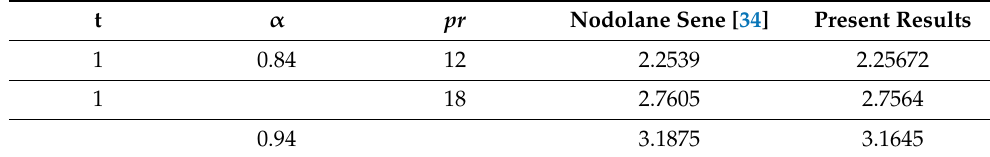
Table 2. Comparison of Nusselt number when φ =